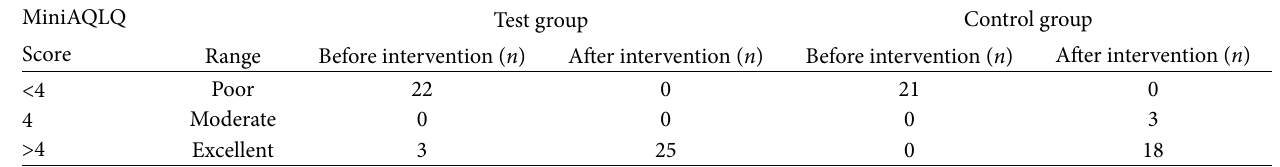
Table 3: Range of QOL in MiniAQLQ score before and after intervention.